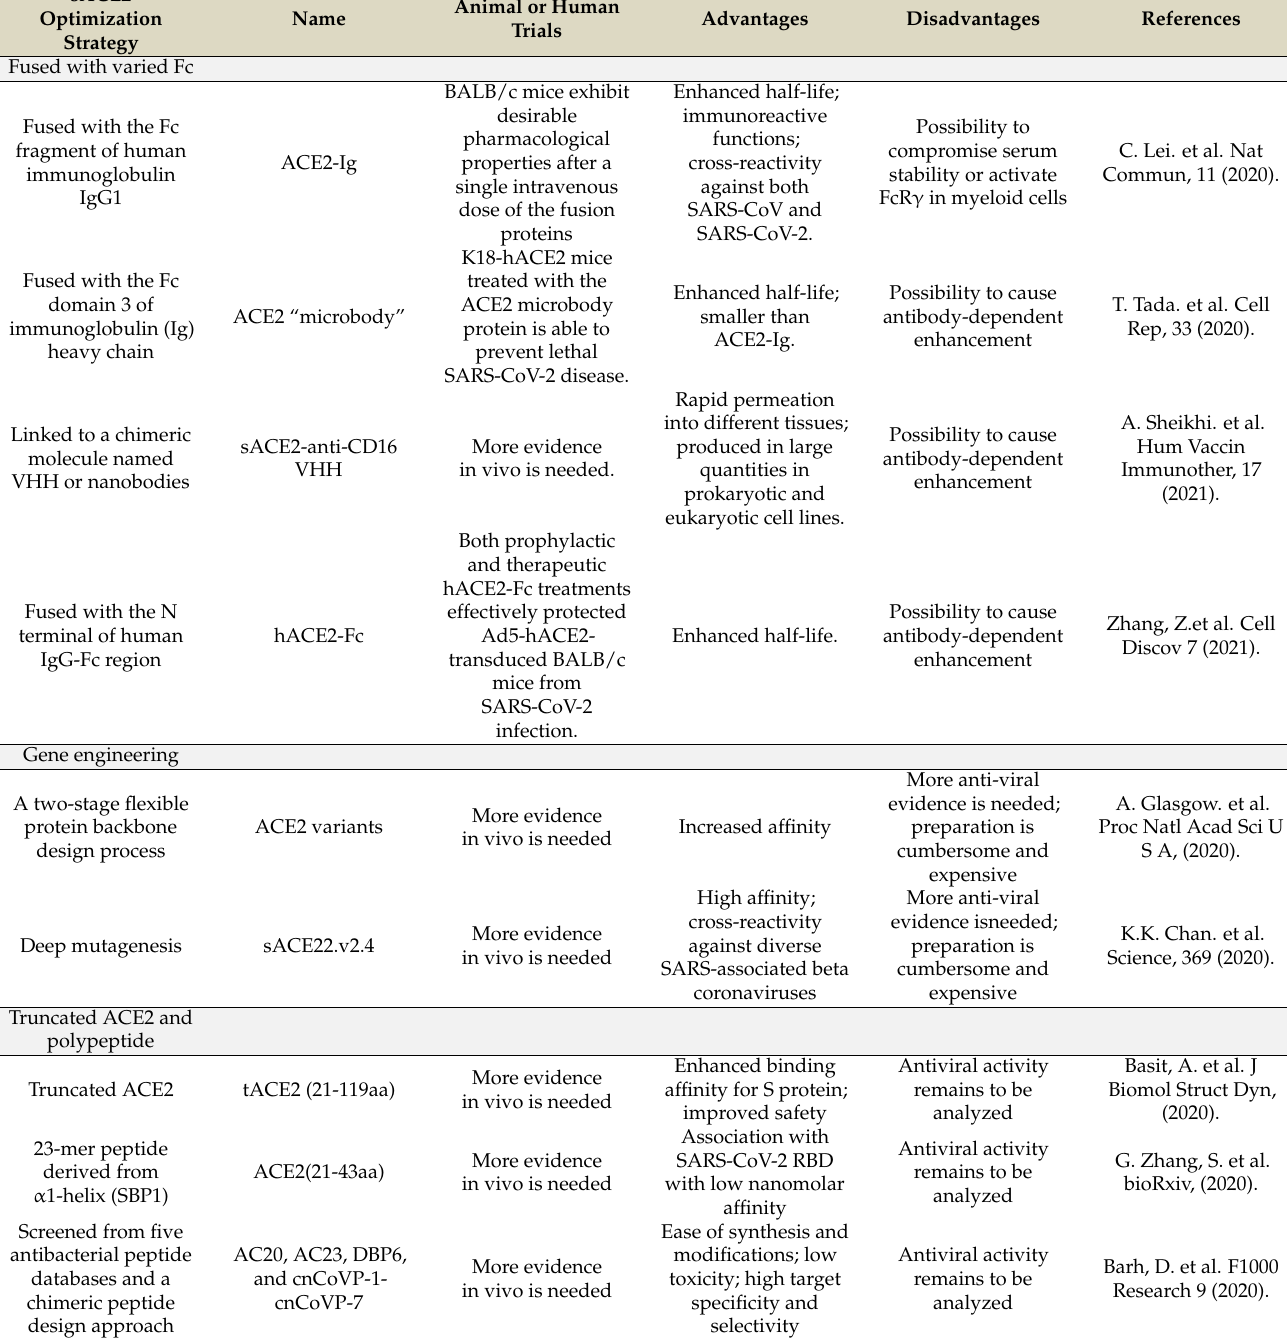
Table 1. Summary of current strategies to optimize the sACE2-based therapeutic agents against SARS-CoV-2 infection. sACE2